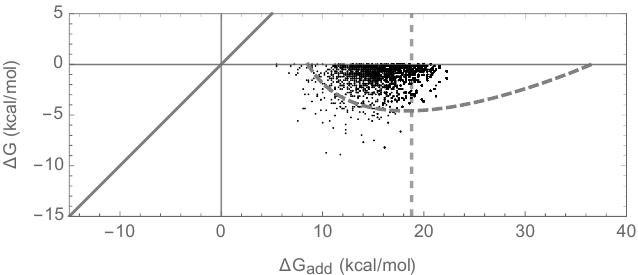
Figure 5. Joint distribution of ∆ G of folding and the additive contribution to ∆ G of folding for the independent epistasis model with σ 2 chosen so that the bivariate normal approximation HOC matches the bivariate normal approximation shown in Figure 1g. Simulations conducted under the = 1 kcal 2 /mol 2 , σ 2 = 21.6 kcal 2 /mol 2 . independent epistasis model with µ add = 1 kcal/mol, σ 2 HOC add A dashed curve shows the area predicted to include 95% of sequences at stationarity under the bivariate normal approximation; the dashed vertical line at ∆ G add = 18.8 reflects a value, derived using a crude percolation theory argument, for the right-most edge of the region where the bivariate normal approximation is expected to be